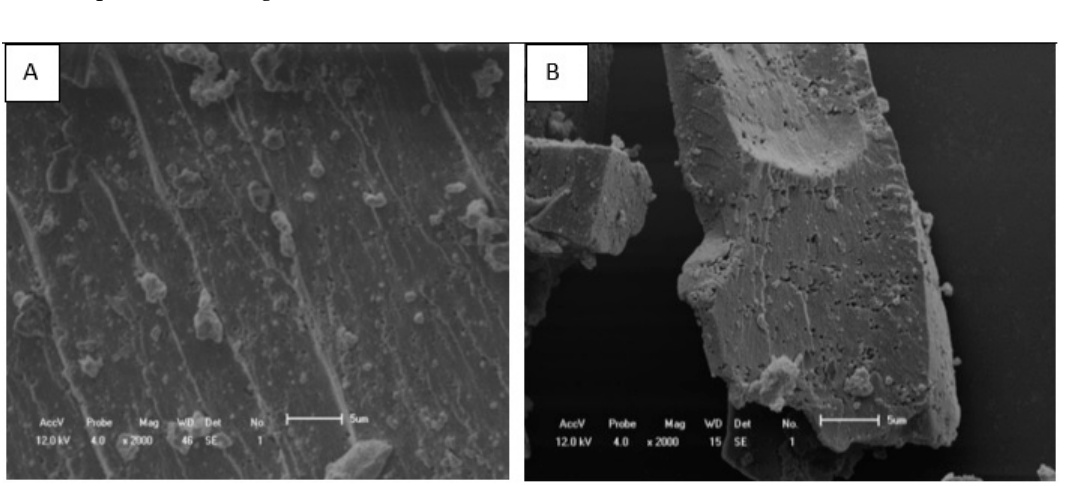
Figure 3. BET ( A ) and Nitrogen adsorption and desorption isotherm ( B ) for CS and CSP.